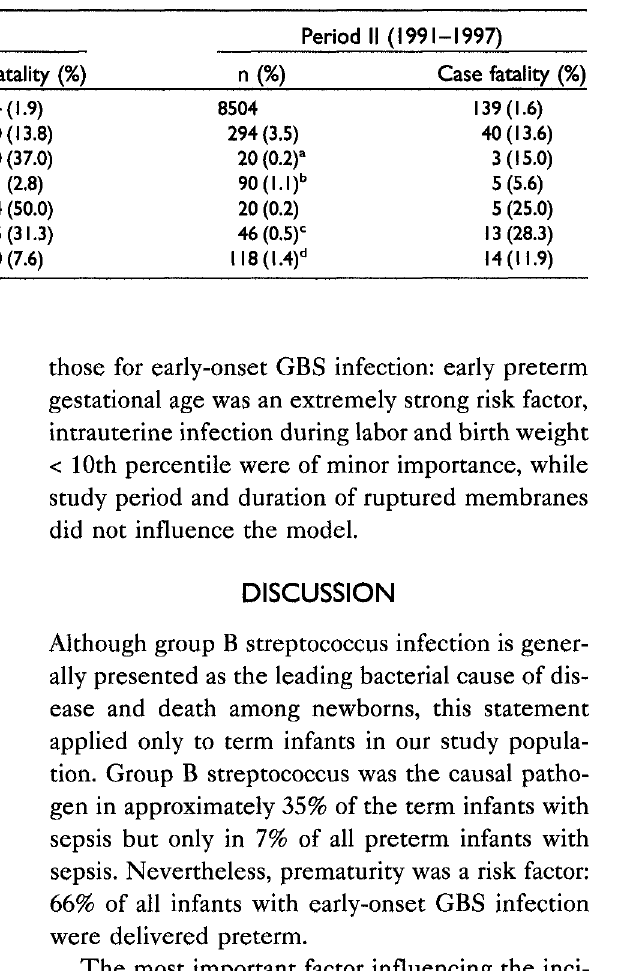
TABLE 3. The number and case fatality of all infants in both periods classified as having sepsis caused by group B streptococcus (GBS), Staphylococcus species. Escherichia coli, other pathogens, and infants with clinical sepsis without bacteriological confirmation